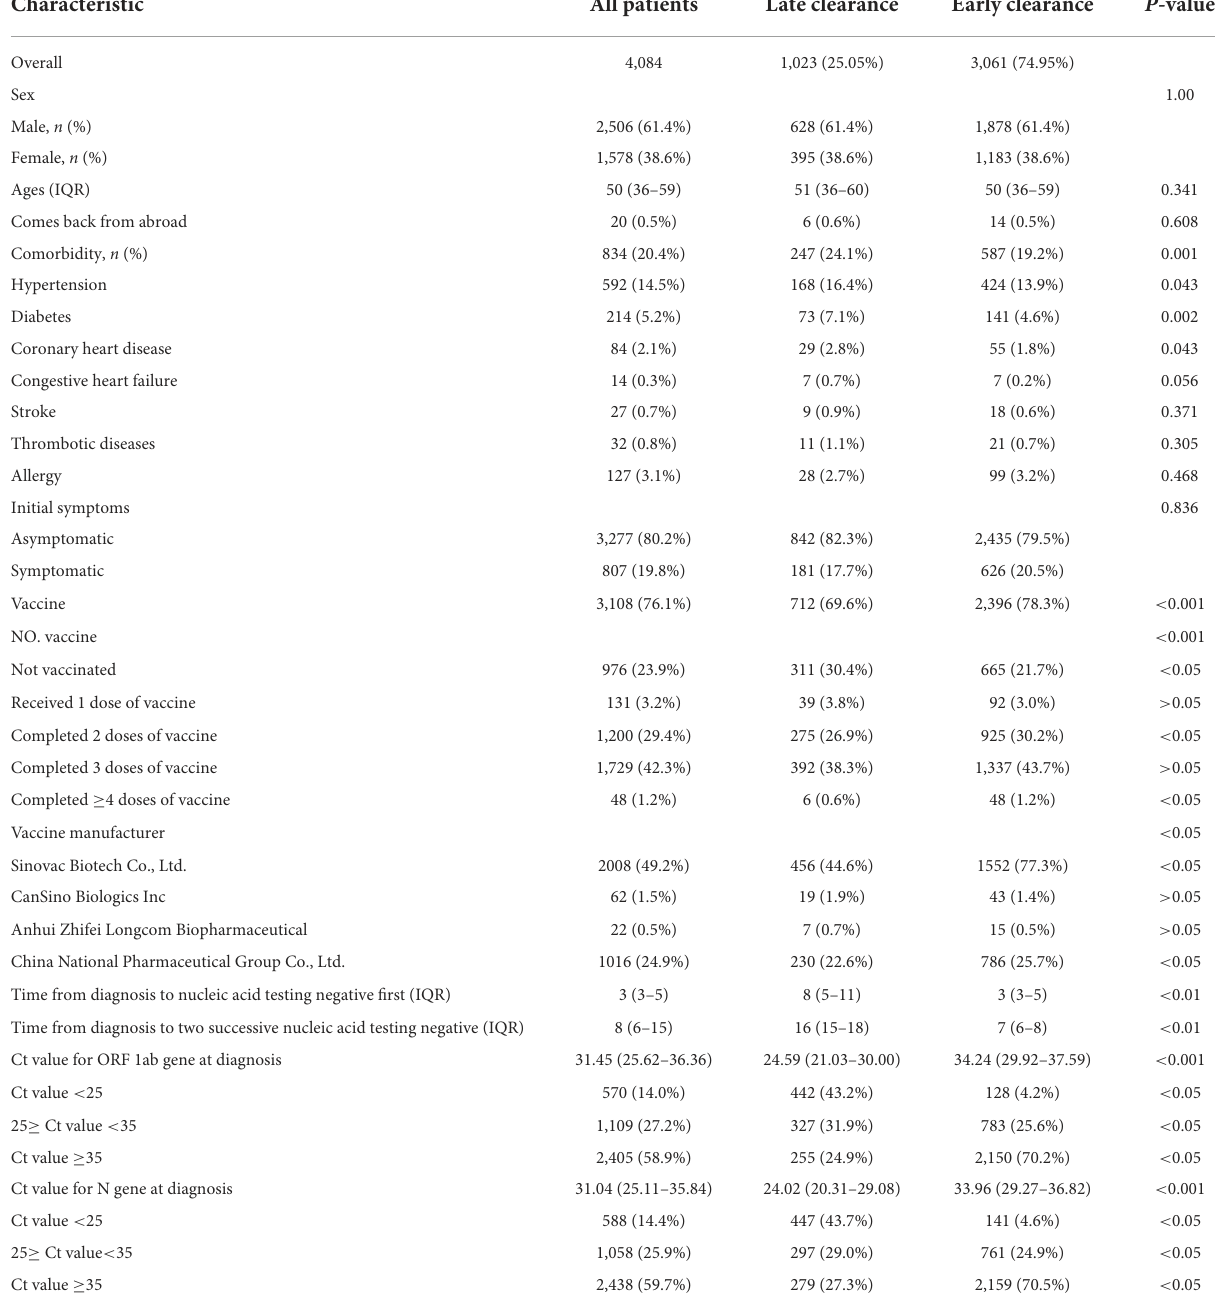
TABLE 1 Characteristics of included cases and controls tested for SARS-CoV-2 in Shanghai access to testing, China, April 1–June 1,